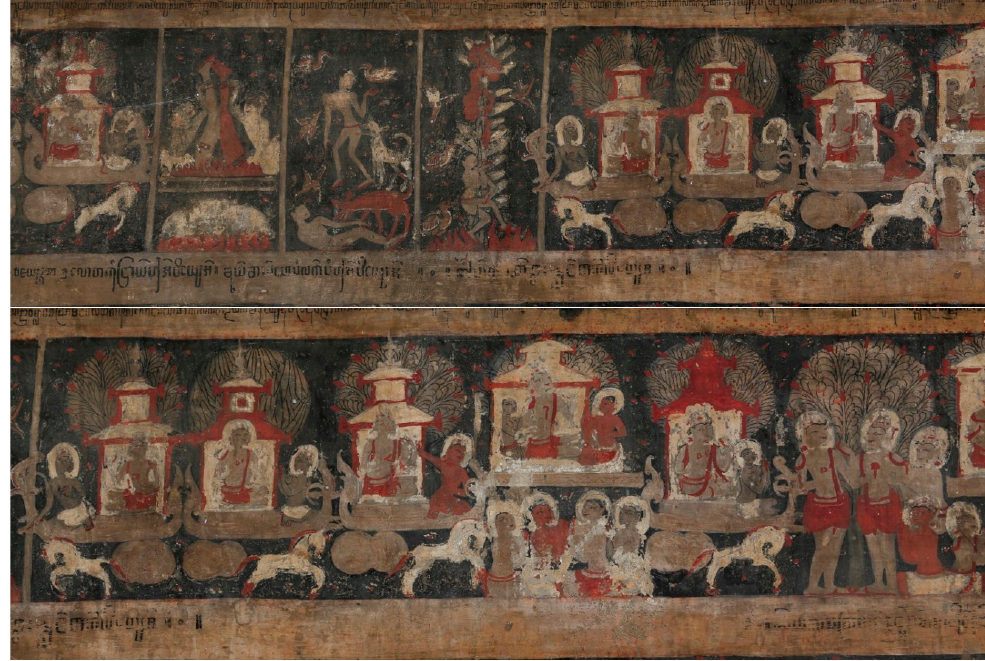
Figure 37. Pagan, Lokahteikpan, 12th century. Two segments of the Nimi J ā taka—visit to hell and visit to one vim ā na.